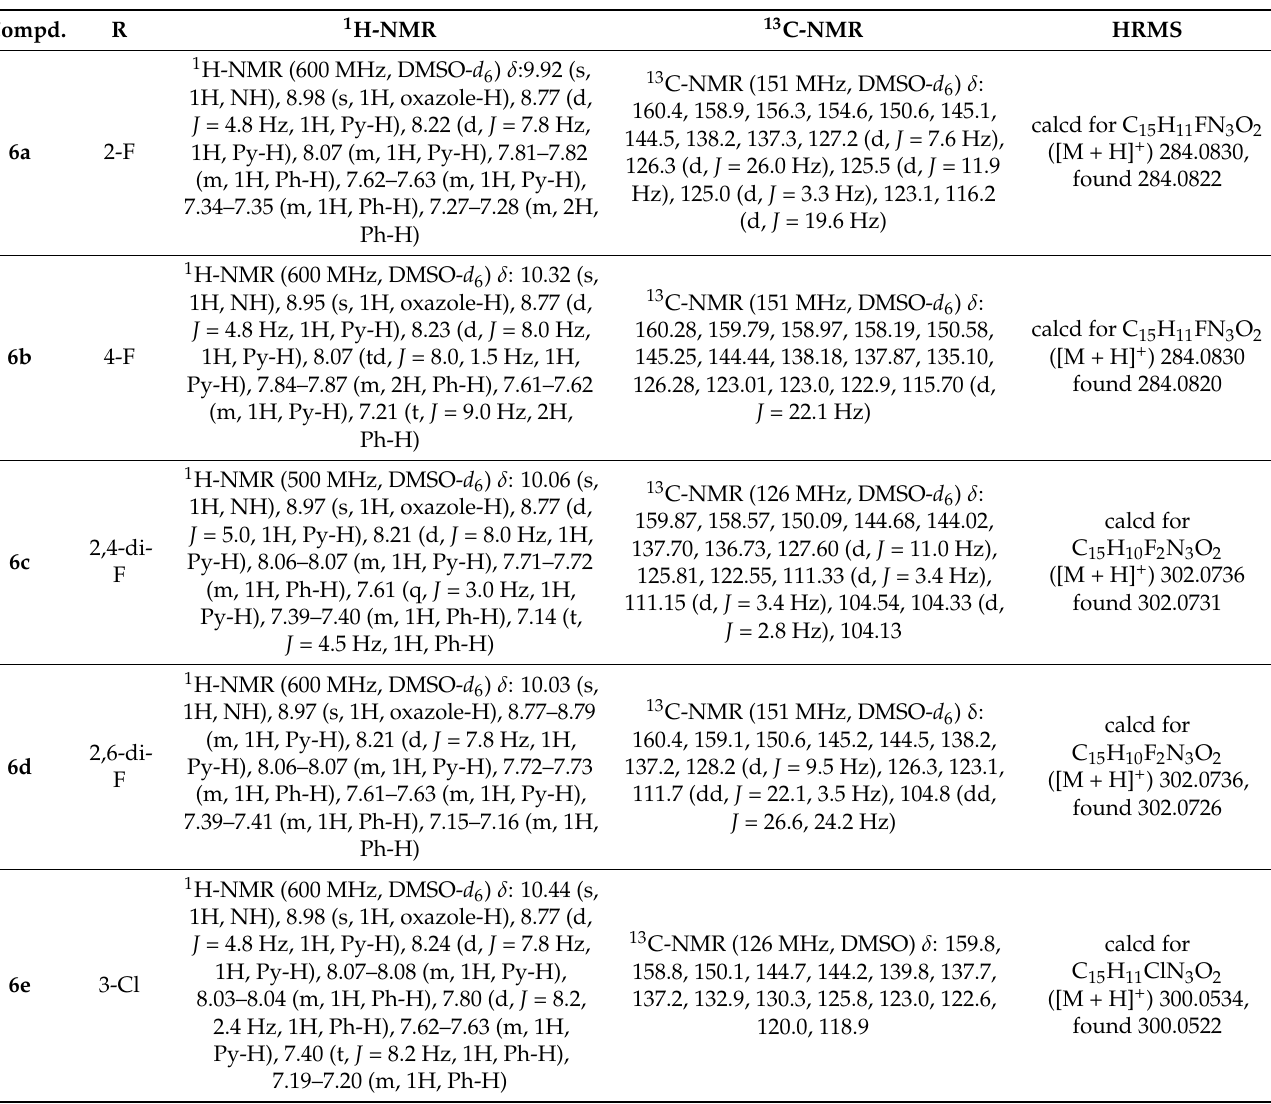
Table 3. 1 H-NMR, 13 C-NMR and HRMS of compounds 6a – 6h